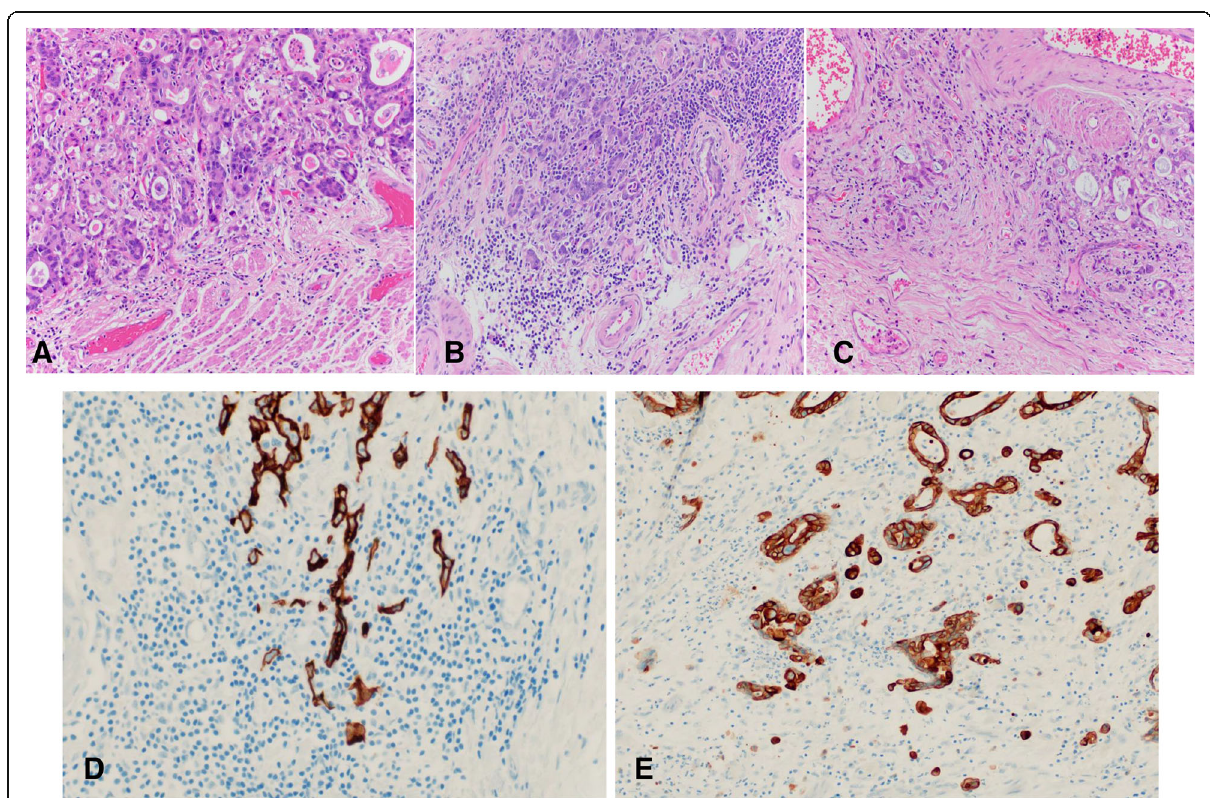
Fig. 4 A . Low tumor budding. B . Intermediate tumor budding. Hematoxylin and Eosin stain ×400. C . High tumor budding. Hematoxylin and Eosin stain ×200. D . Pankeratin immunostain with intermediate tumor budding, ×400. E . Pankeratin immunostain with high tumor budding, ×400